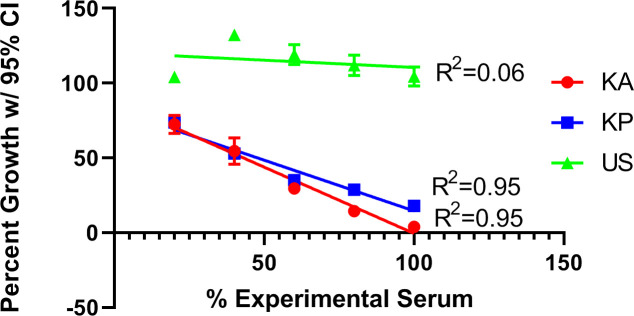
Plot of % parasite growth at 95% confidence index (CI) in various sera background vs. content of patient serum (Kenyan adult, Kenyan pediatric, US adult), as % of total serum used in each treatment (with commercial Sigma serum representing the remainder).